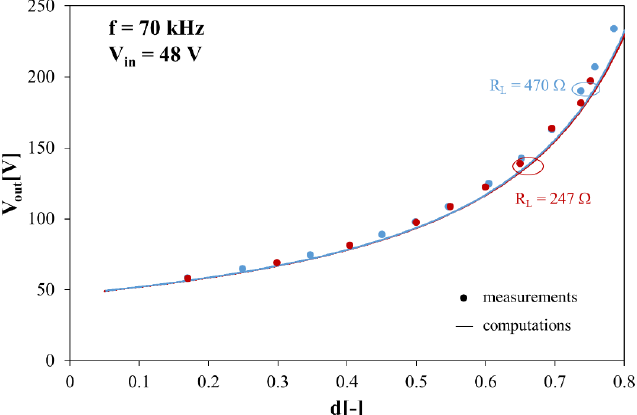
Figure 8. Computed values of the relative error in determining the output voltage as the function of the converter output current.